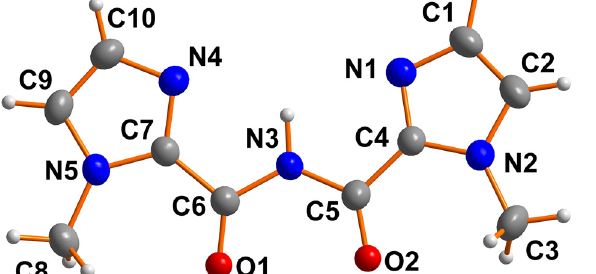
Table  : Data collection and